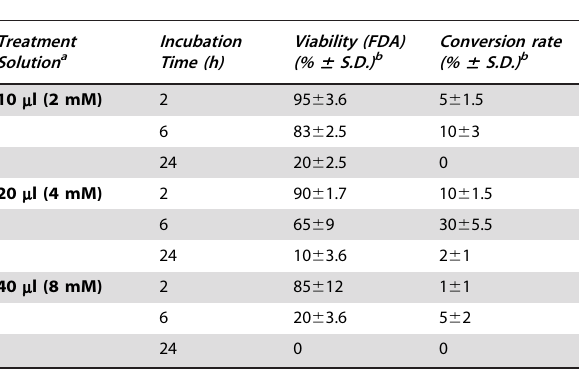
Table 2. Detergent-resistance percentage (conversion rate) of E. histolytica trophozoites treated with treatment solution at different